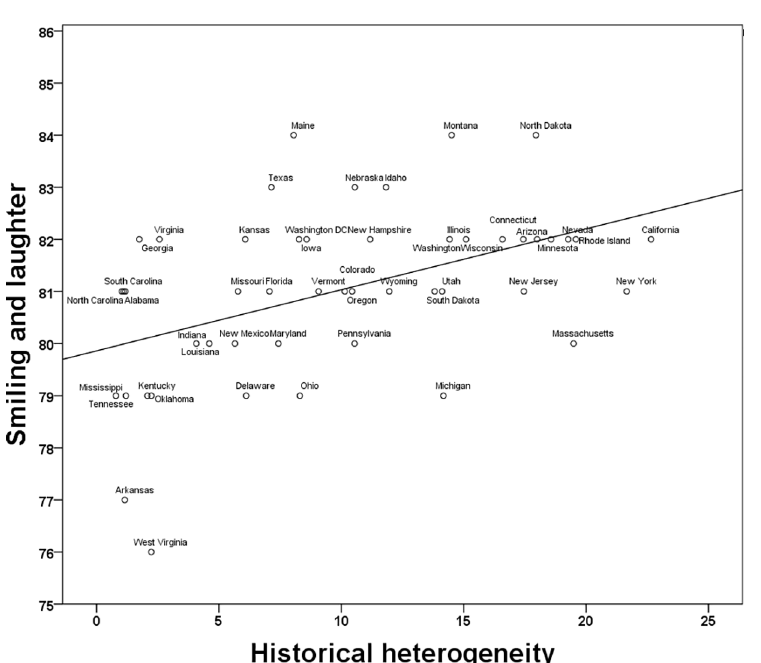
Fig 4. Smiling and laughter as a function of state-level historical